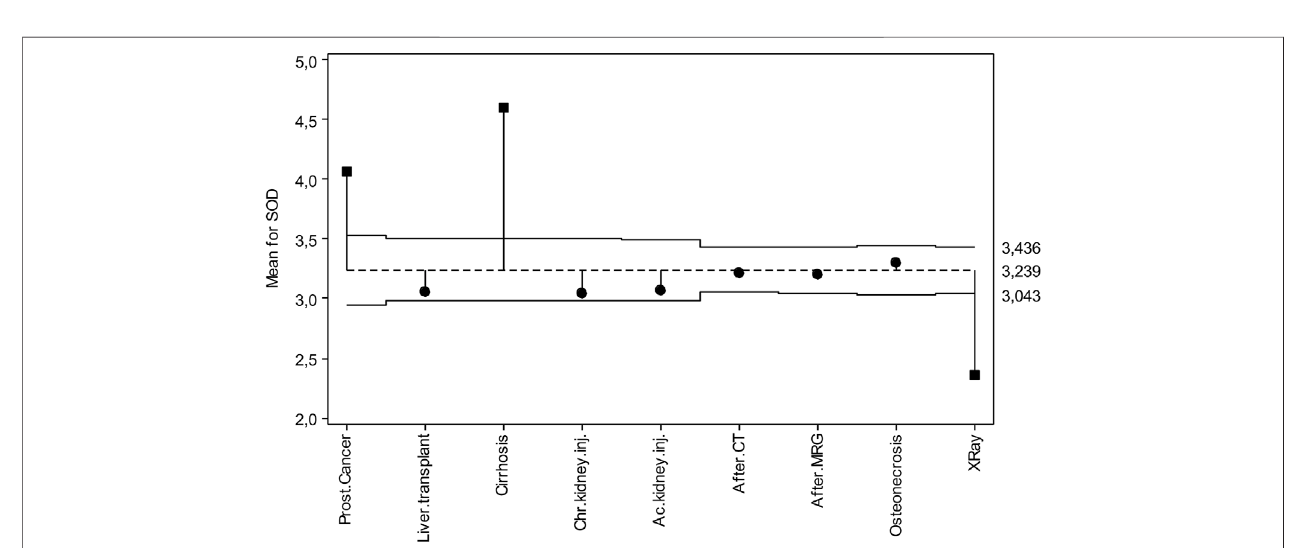
FIGURE 2 | ANOM diagram for SOD